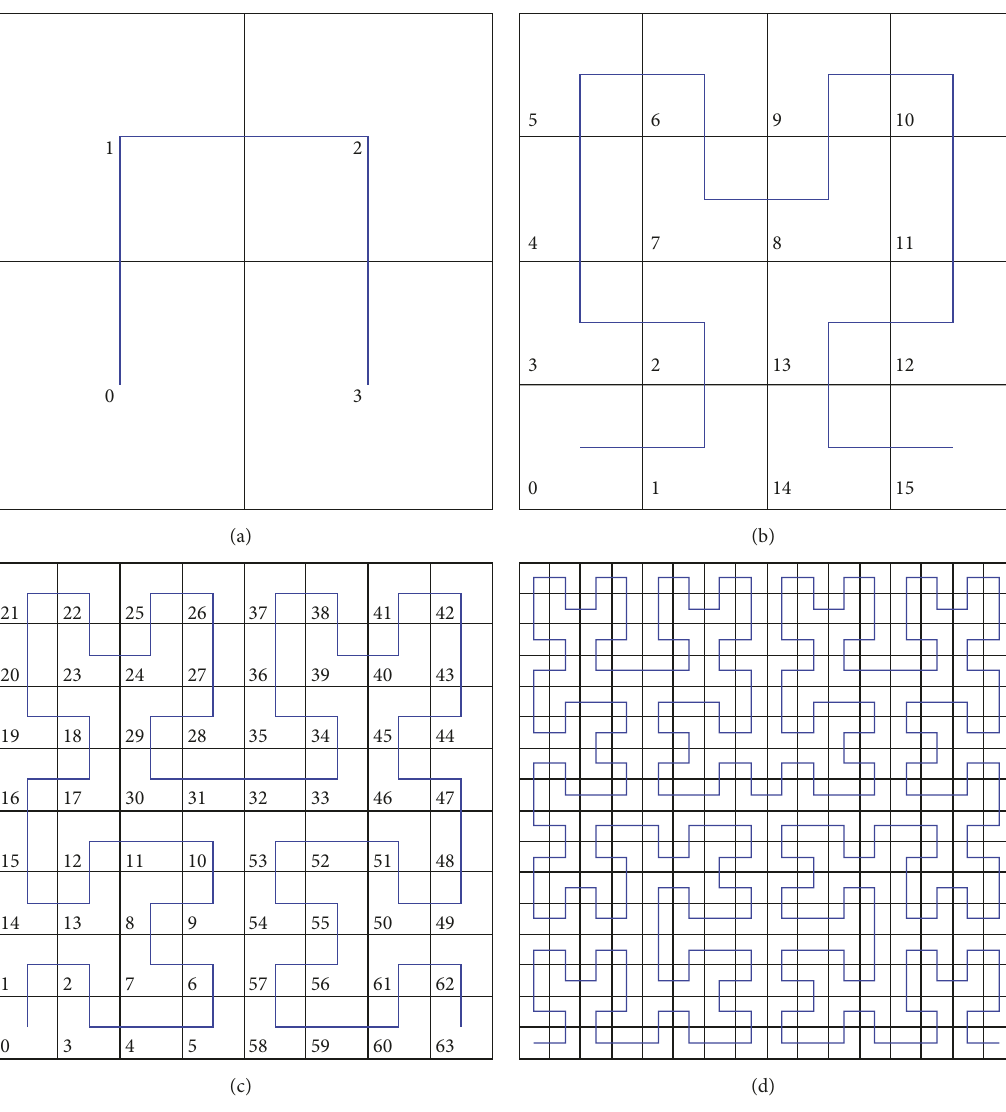
Figure 1: (a) Hilbert curve of order 𝑁 = 1 . (b) Hilbert curve of order 𝑁 = 2 . (c) Hilbert curve of order 𝑁 = 3 . (d) Hilbert curve of order 𝑁 = 4